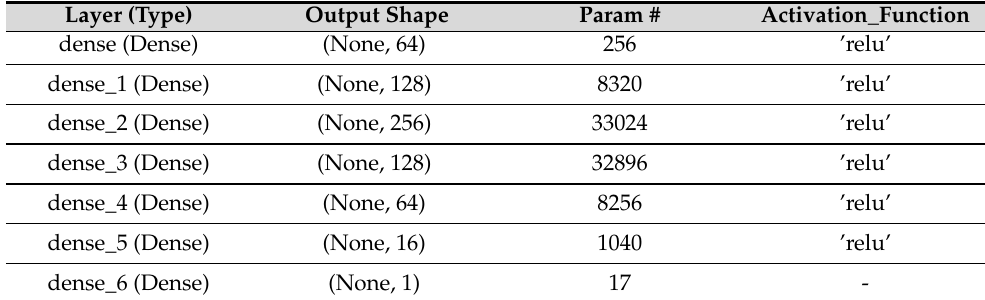
Table 6. Deep layer neural network structure to make an SPV Power Plant model. Layer (Type) Output Shape Param #